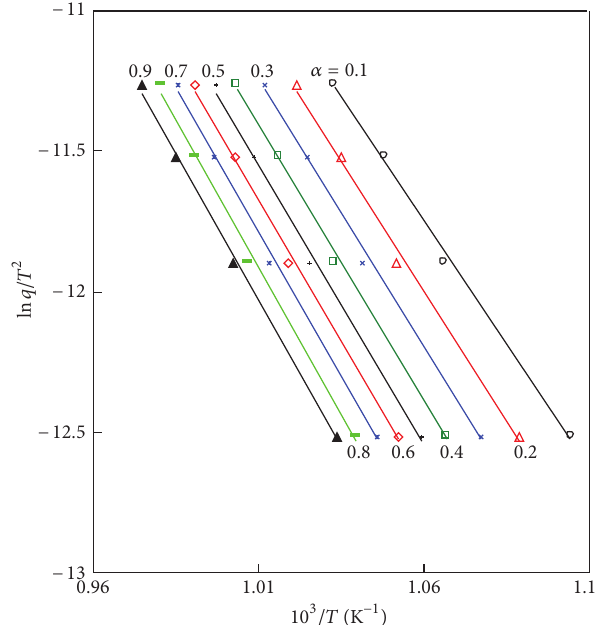
F 5: Plots of Ozawa-Flynn-Wall equation for the thermal . F 6: Plots of Kissinger-Akahira-Sunose equation for the degradation of reagent-grade CaCO thermal degradation of reagent-grade CaCO 3